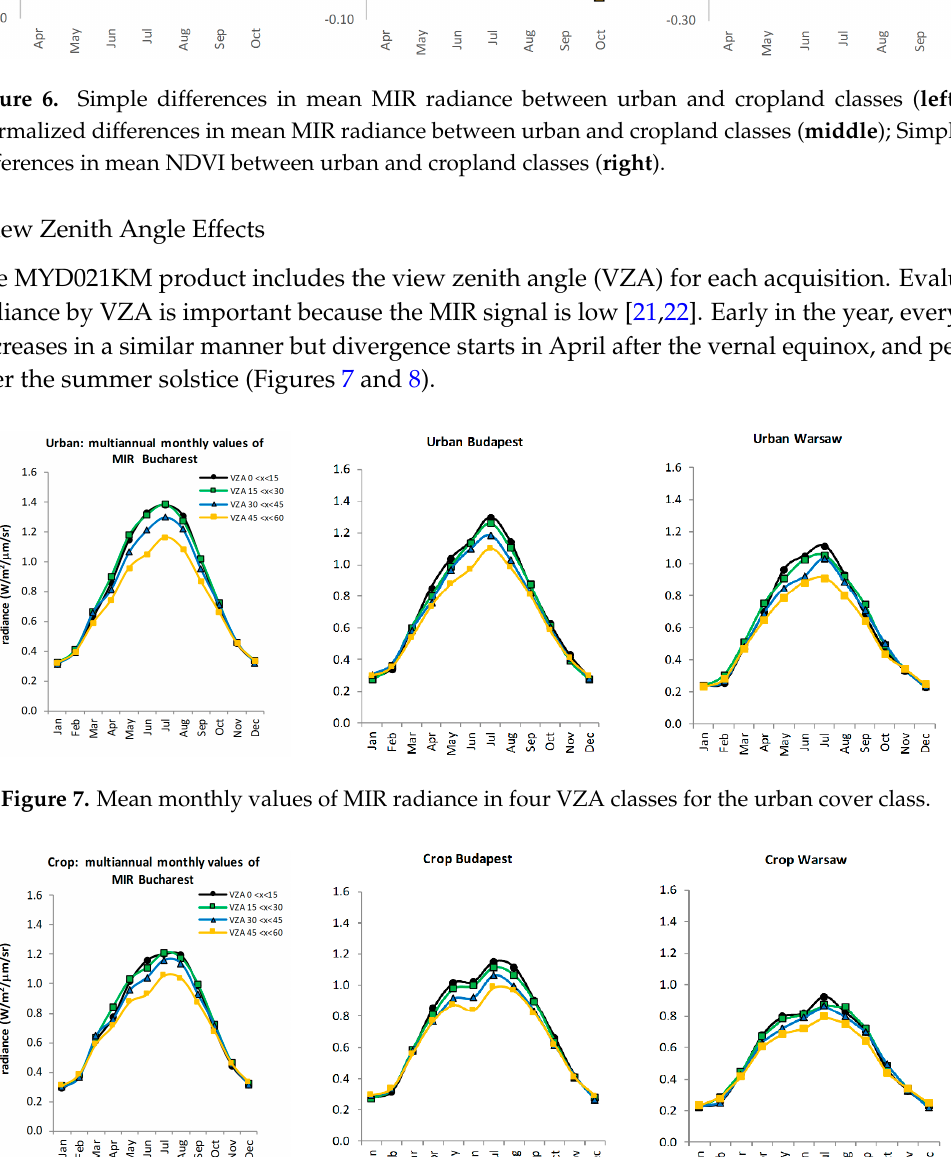
Figure 8. Mean monthly values of MIR radiance in four VZA classes for the cropland class.